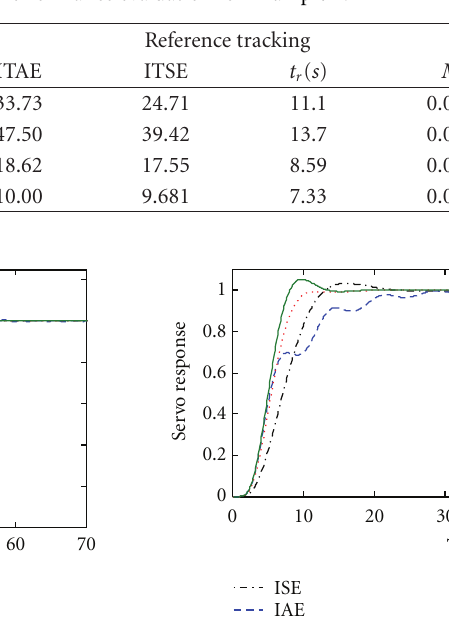
Figure 10: I-PD controller performance, (a) process output, (b) controller output. Table 4: Performance evaluation for Example 2.